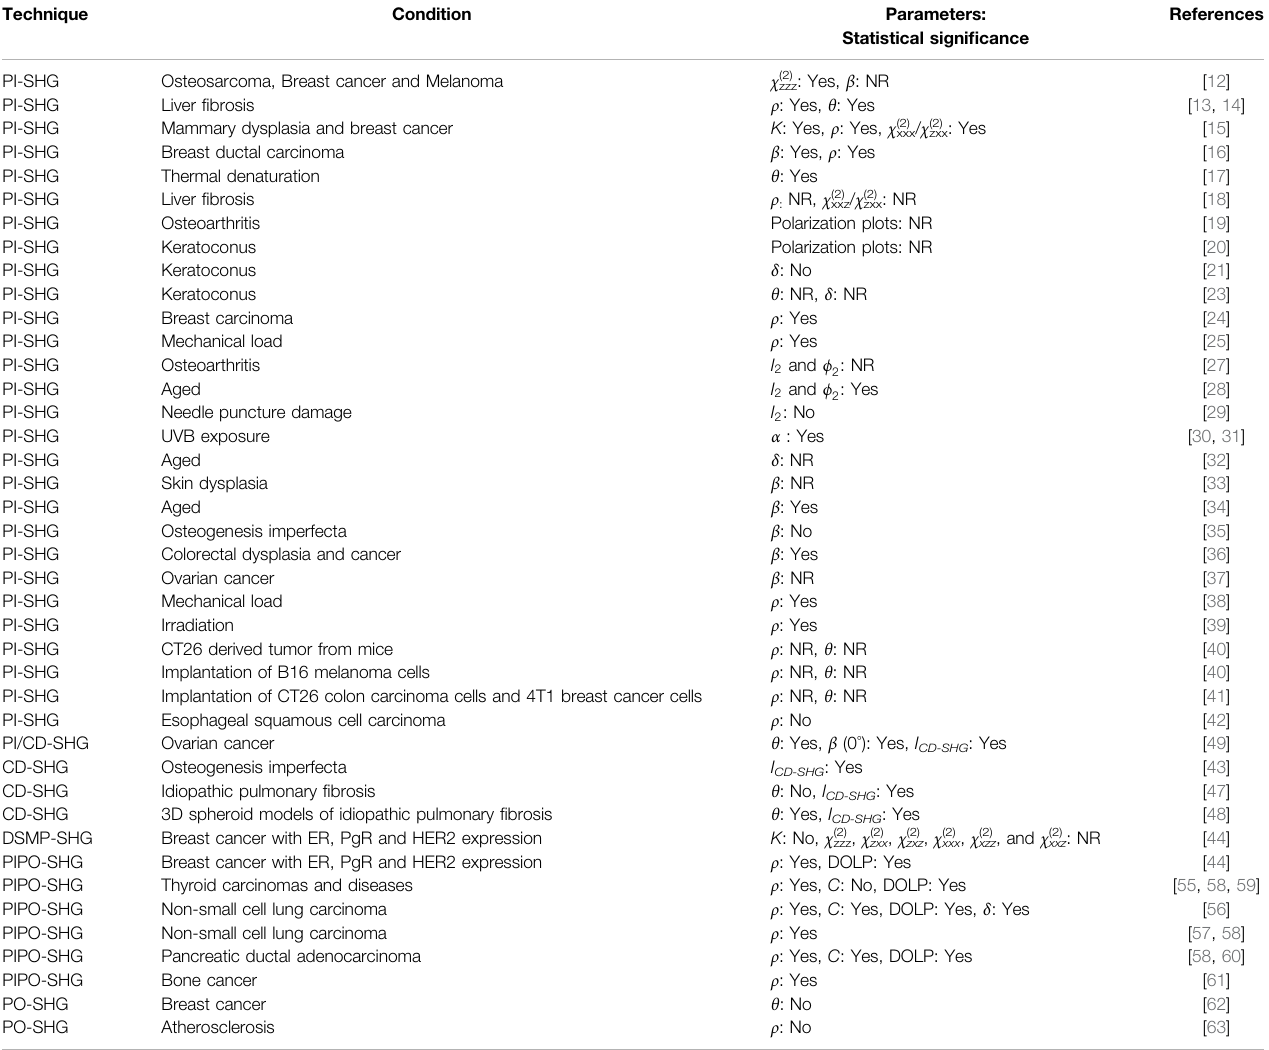
TABLE 1 | A summary of the PSHG microscopy techniques used for quantifying the differences in collagen structure in diseased tissue and the corresponding parameters measured with those techniques. The following abbreviation is used NR: Not reported. Technique Condition Parameters: